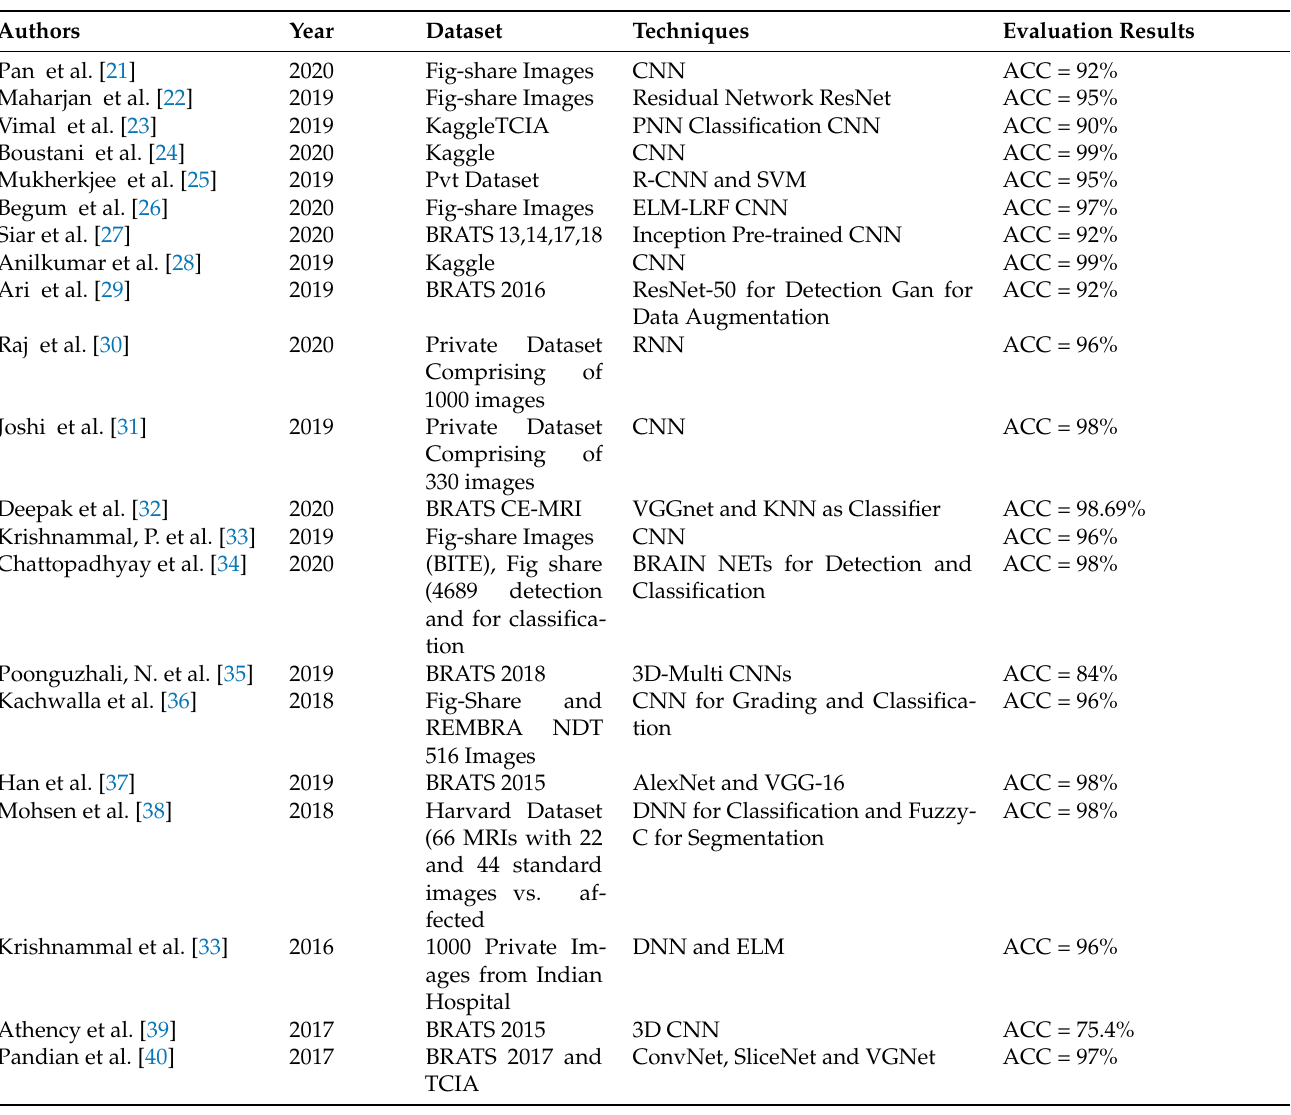
Table 1. Summary of the Related